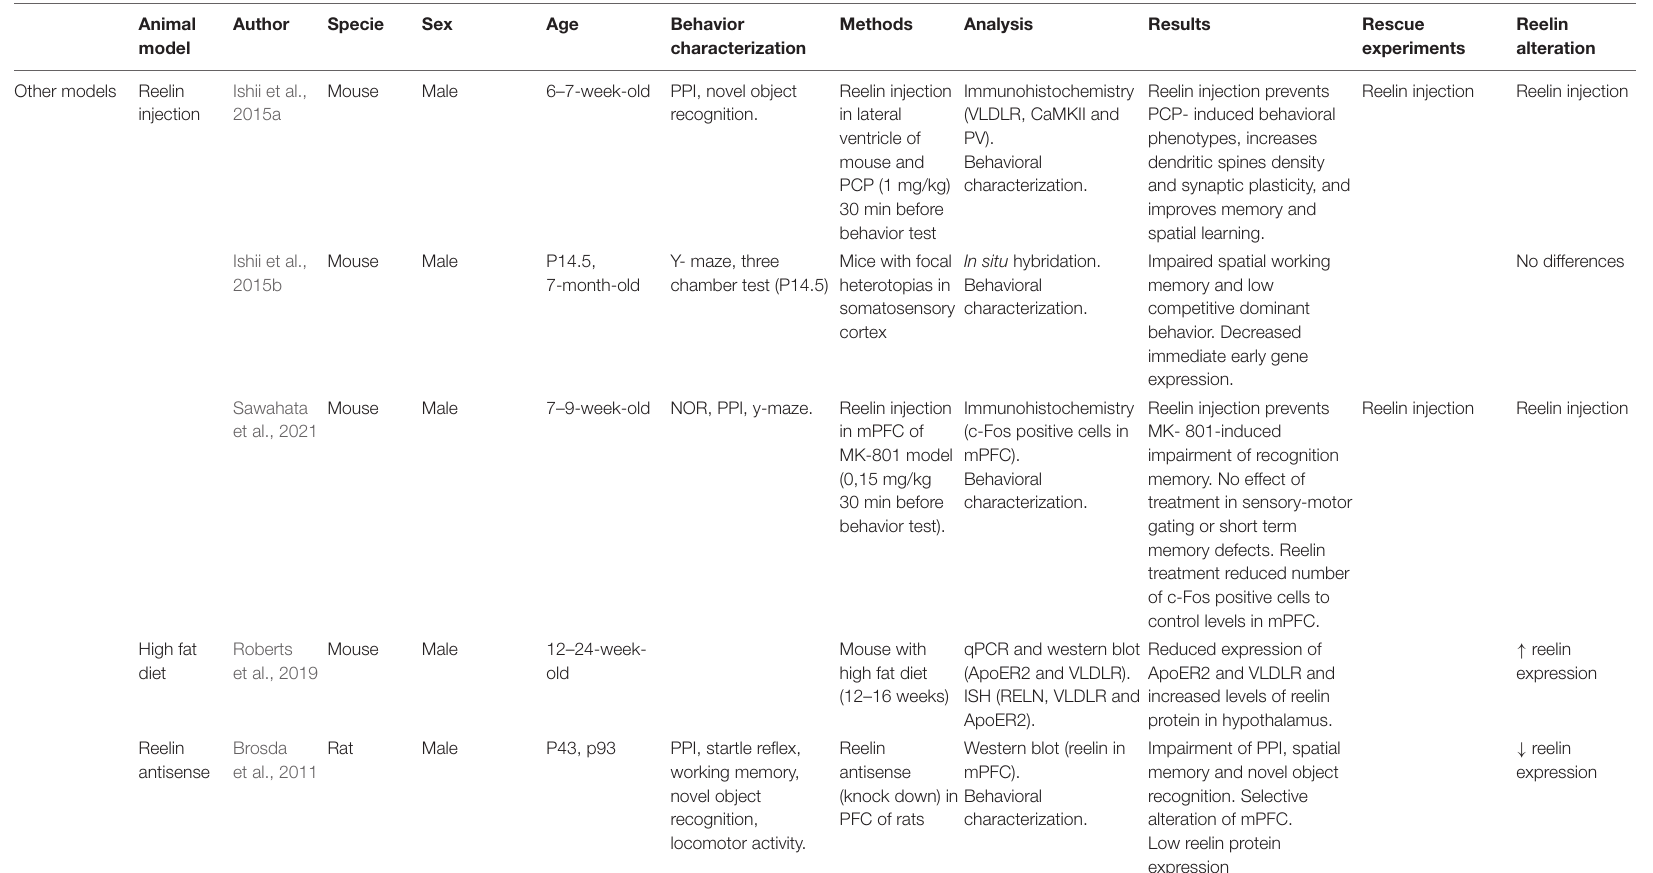
TABLE 5 | Principal findings of other model studies included in this